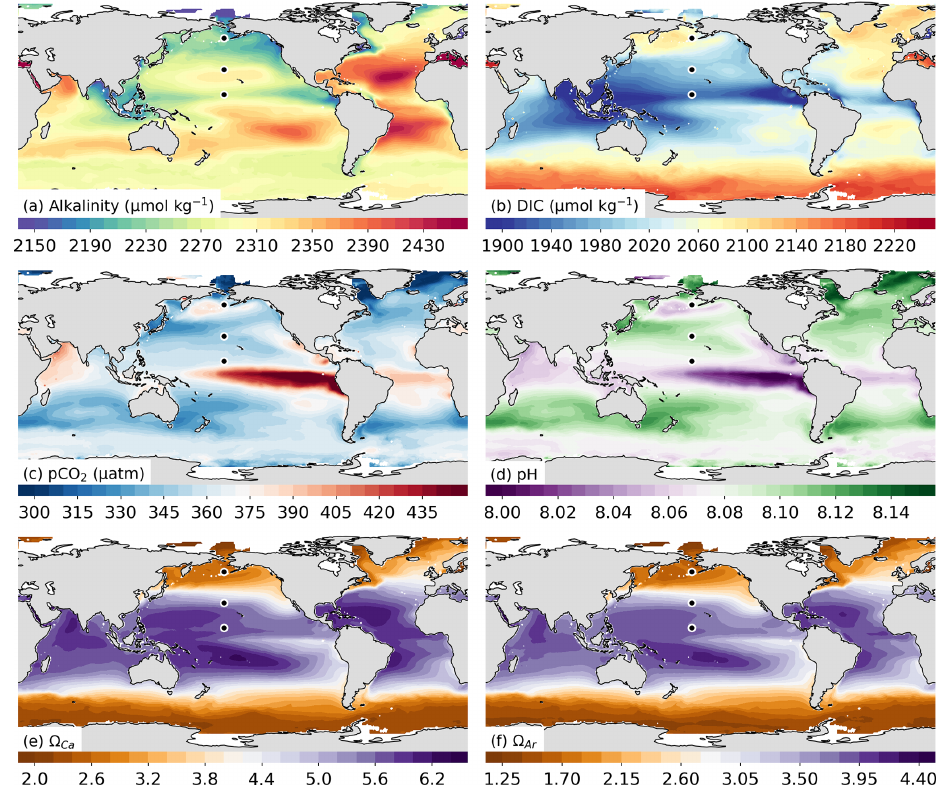
Figure 10. Mean maps of the GRaCER-based estimates for the period 1985–2018 for (a) total alkalinity and (c) p CO 2 , as well as those of the computed variables, (b) dissolved inorganic carbon, (d) pH, (e) (cid:127) calc (saturation state with regard to calcite), and (f) (cid:127) arag (saturation state with regard to aragonite). The three black markers in each plot show the locations chosen for the seasonal analysis in Fig. 11f–j.